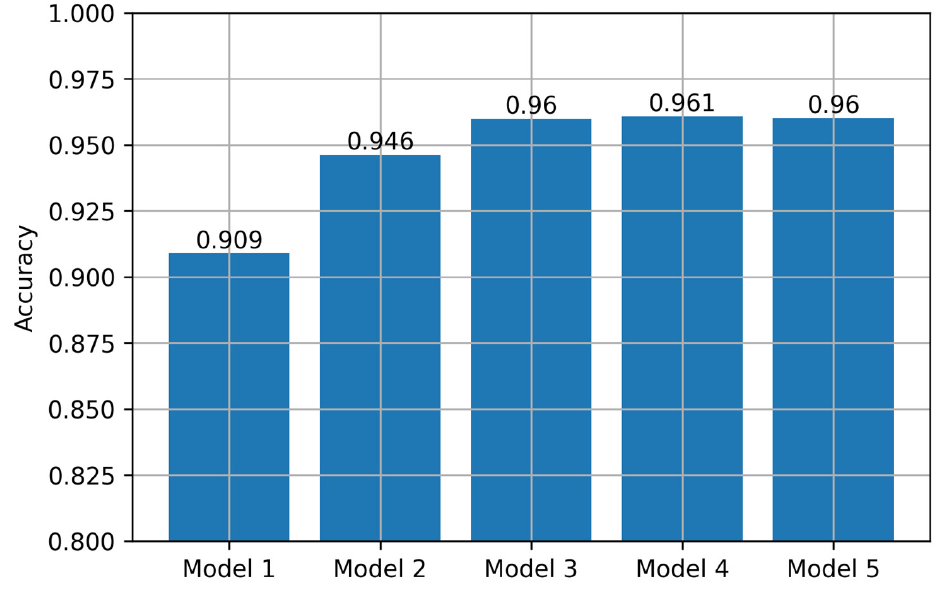
Figure 13. Learning curves of a VGG16 model with data augmentation.